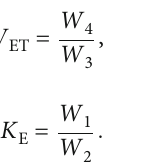
K ET and E of samples with di